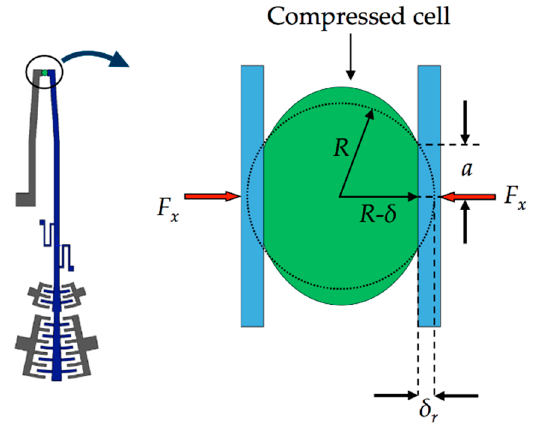
Figure 11. Schematic view of the Hertzian mechanics model for large deformations used to estimate the resistive force of a cell.